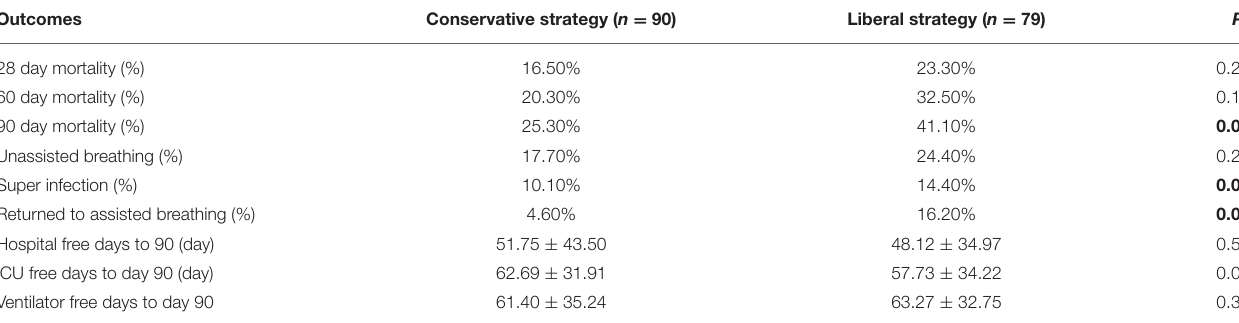
TABLE 1 | Secondary outcomes in phenotype 2.